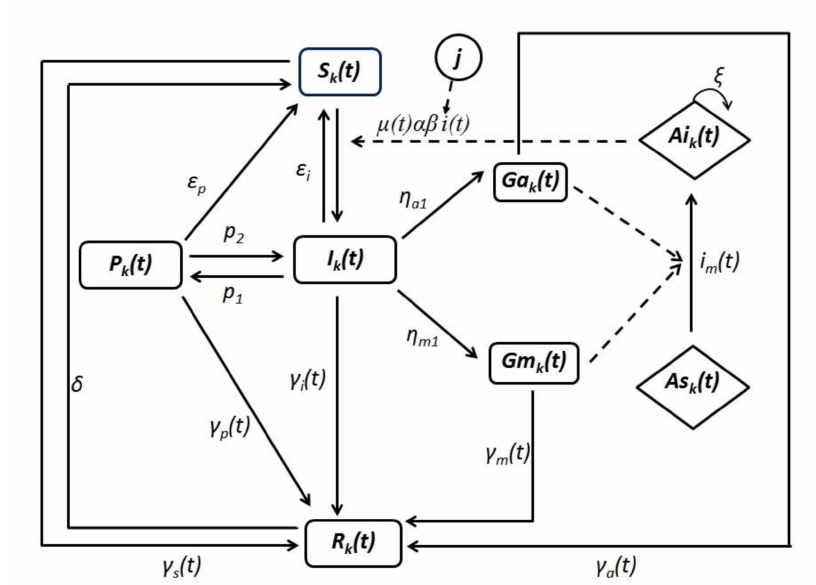
Figure 2. Malaria transmission diagram at a local village k . Letter j stands for remote